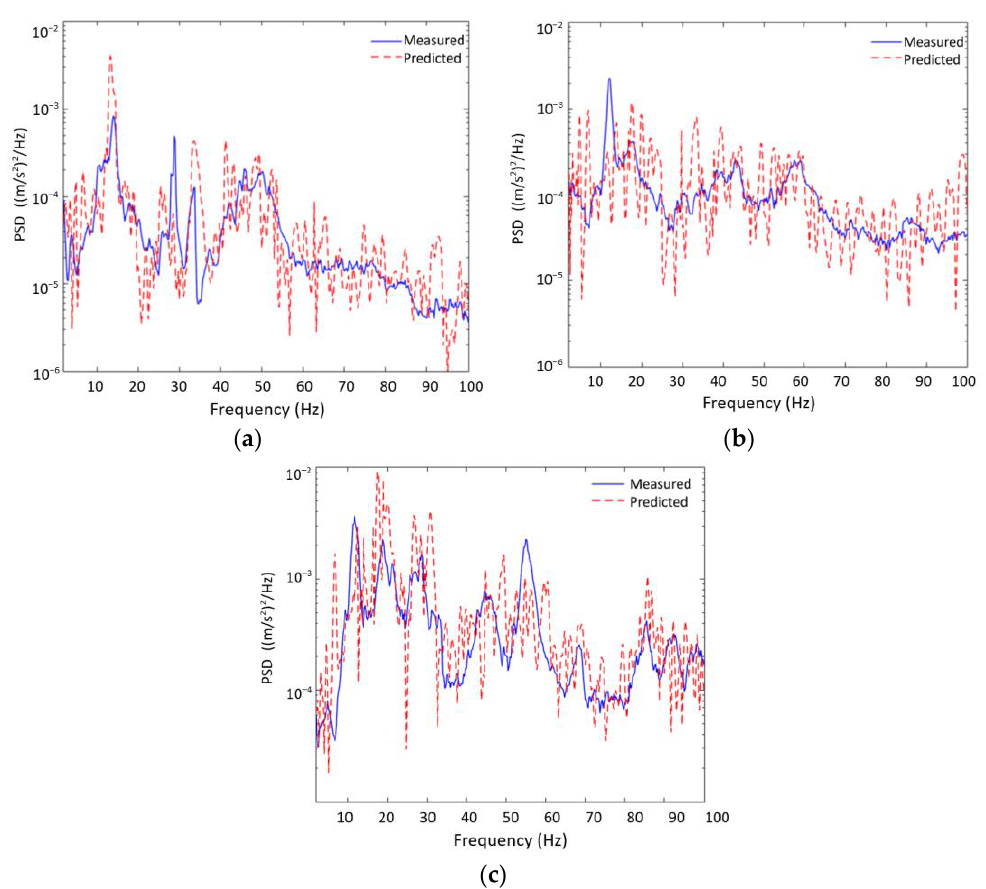
Figure 6. Comparisons between the predicted and measured PSDs of the acceleration of the carriage floor. ( a ) X -direction; ( b ) Y -direction; ( c ) Z -direction.